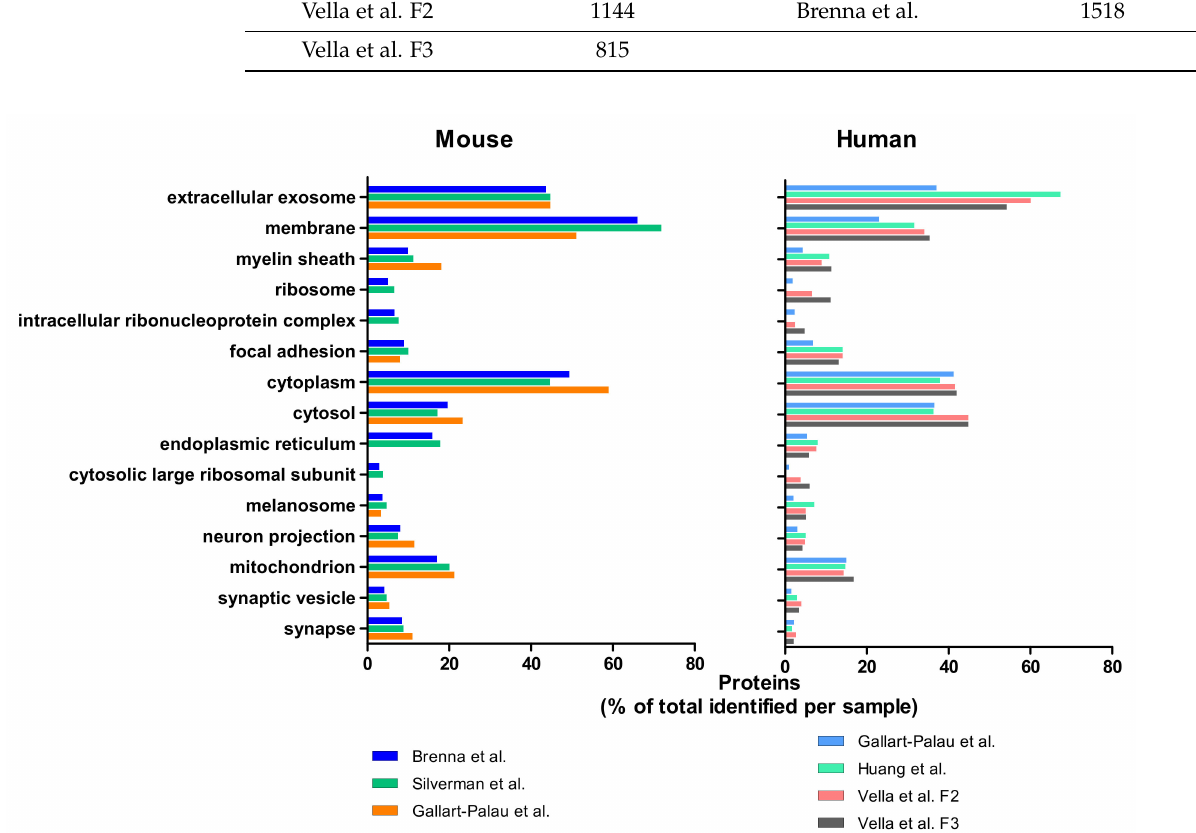
Figure 2. Bar charts of the 15 most enriched GO Cellular Components (GOCCs) in the mouse and human studies. The graph shows the top 15 GOCC detected with DAVID in the mouse studies (on the left) and the human studies (on the